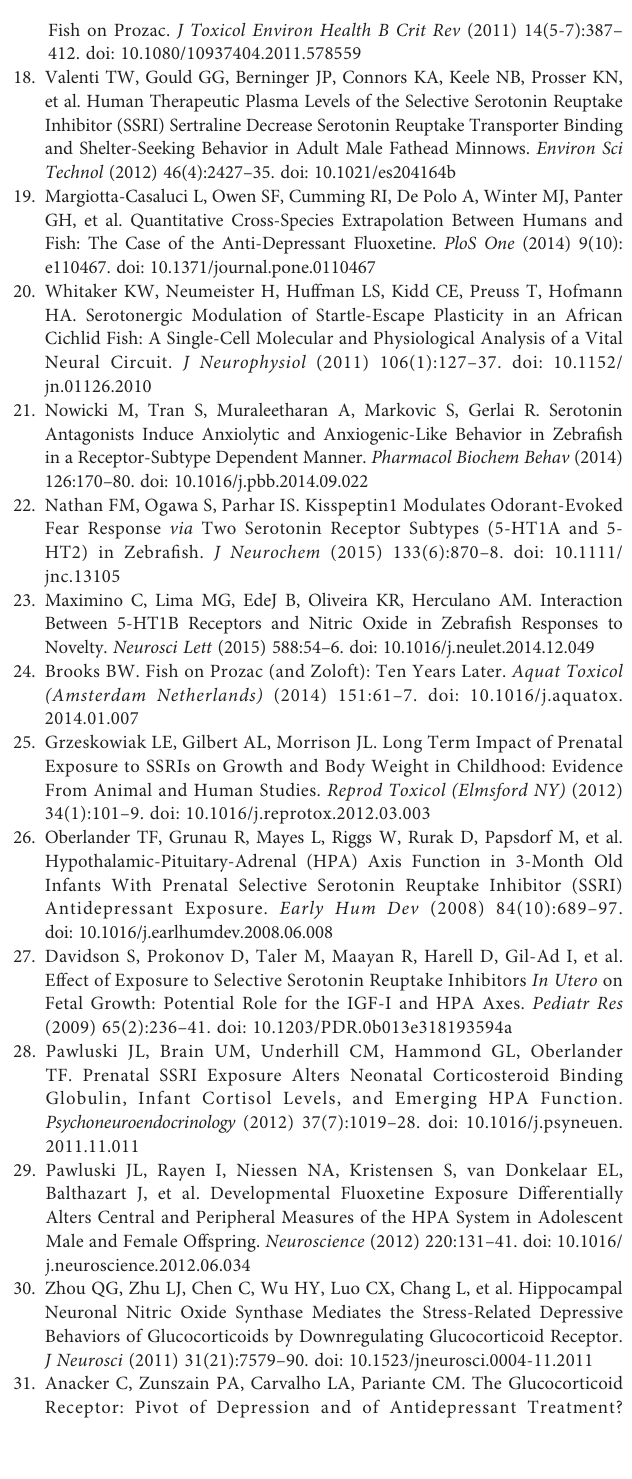
Supplementary Figure 4 | Volcano plots of the mapped transcriptome in fl uoxetine-exposed groups compared to the controls in unstressed and stressed conditions. The volcano plots in the three studied tissues in the unstressed and stressed conditions are shown. The x-axis shows the fold change (FC) on a logarithmic scale. Only genes with FC ≥ 1.2 are depicted here. The y-axis shows the level of signi fi cance on a negative logarithmic scale. The